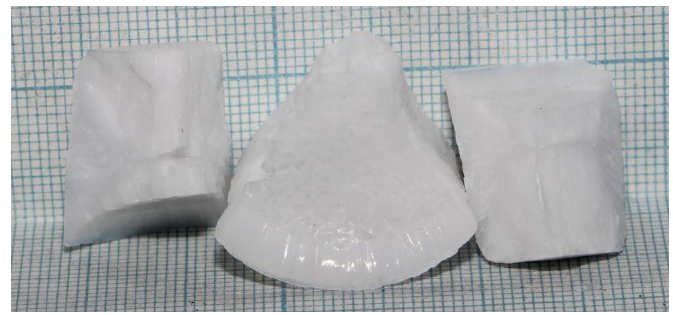
Figure 1. Photo of prepared eutectic FLiNaK.